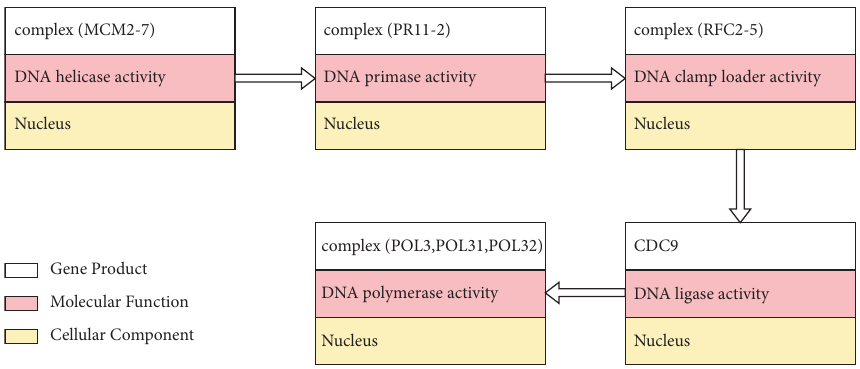
Figure 1: Illustration of three aspects in GO.